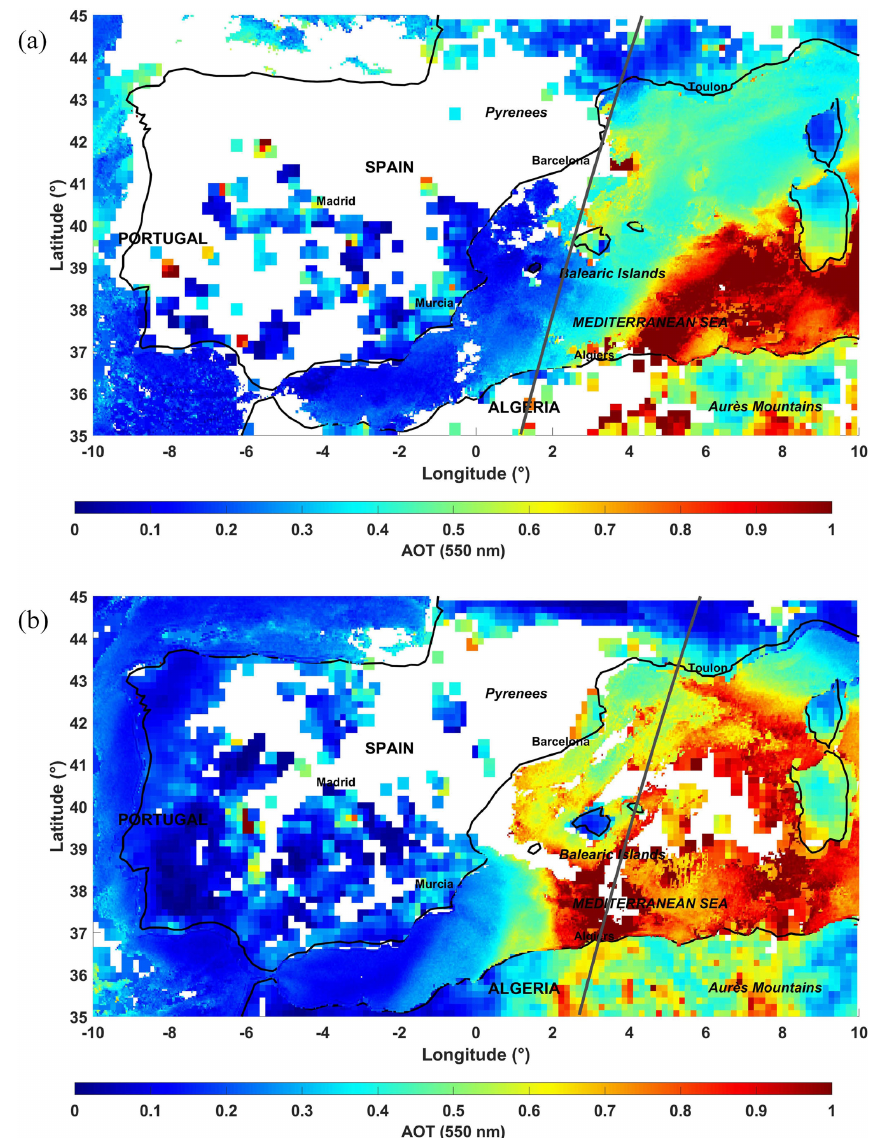
Figure 14. AOT at 550nm derived from the composition of MODIS over land and SEVIRI over sea observations: (a) on 24 June 2014 and (b) on 3 July 2014. The nearest nighttime ( ∼ 02:00UTC) ground tracks of CALIOP are given as dark grey continuous lines.